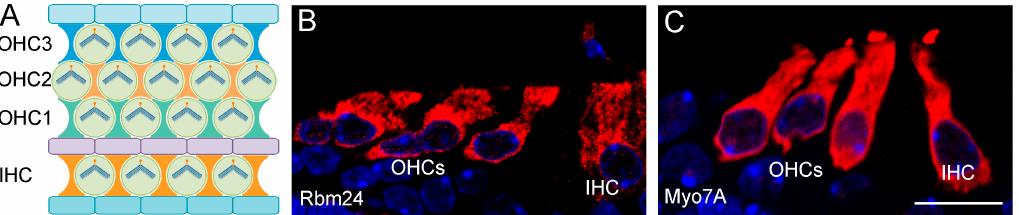
Figure 2. Expression of Rbm24 protein in cochlear hair cells. ( A ) Schema shows the planar cell polarity-dependent organization of hair cells in the organ of Corti [47]. One row of inner hair cells (IHC) and three rows of outer hair cells (OHC1-3) display uniform orientation of arrow-shaped stereocilia, and are rigorously aligned with surrounding supporting cells (represented by different forms and colors). ( B , C ) Immunofluorescence staining of cochlear sections from neonatal mice shows accumulation of Rbm24 (red) and Myo7A (red) in the cytoplasm of IHC and OHCs [44]. Rbm24-positive punctae are present in DAPI-stained (blue) nuclei. Scale bar: 10 µm.